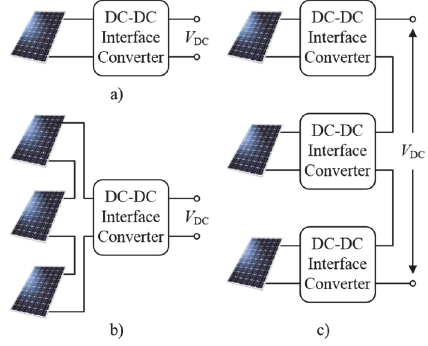
Fig. 1. The main possible configurations of a DC-DC PV